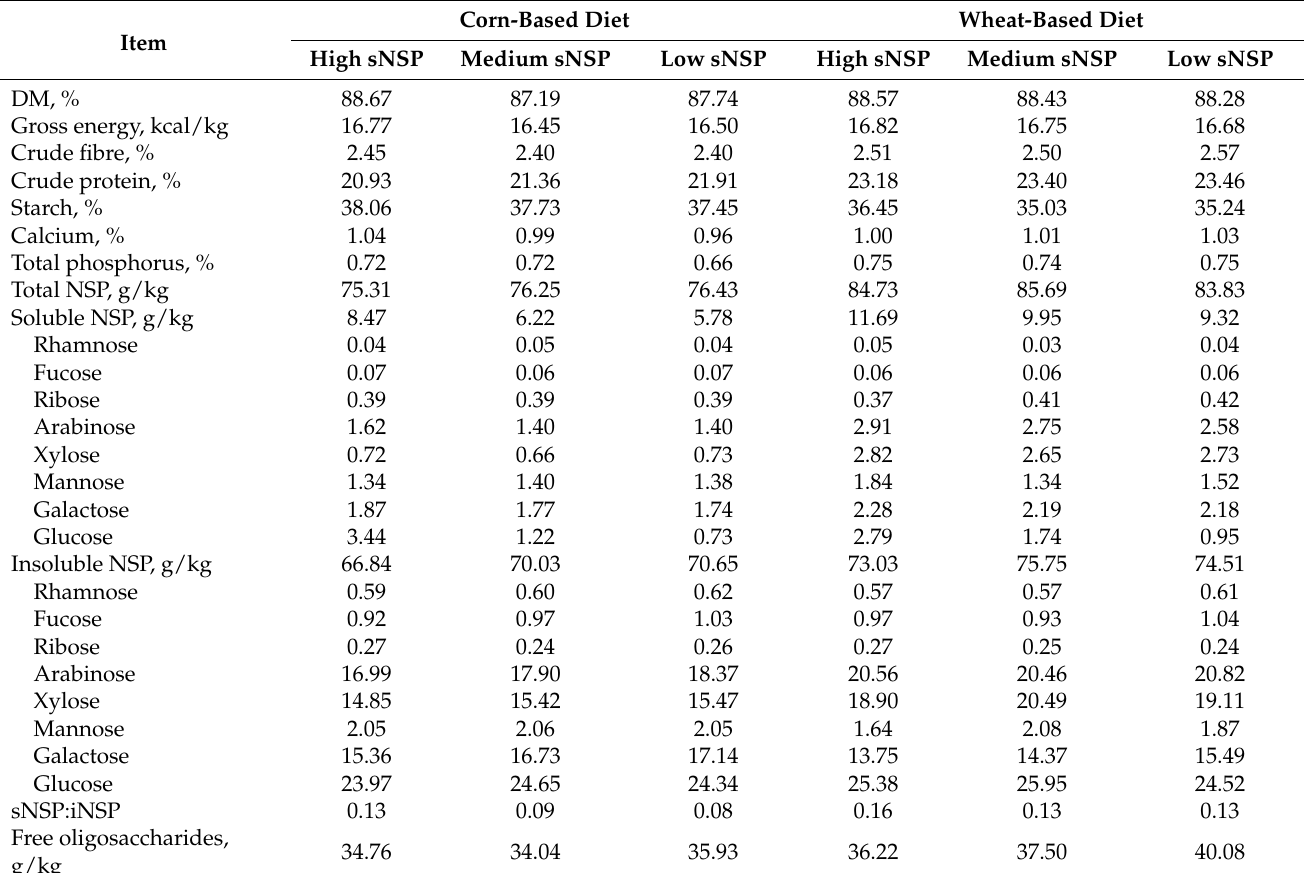
Table 4. Analysed nutrient composition of starter diets (as-fed